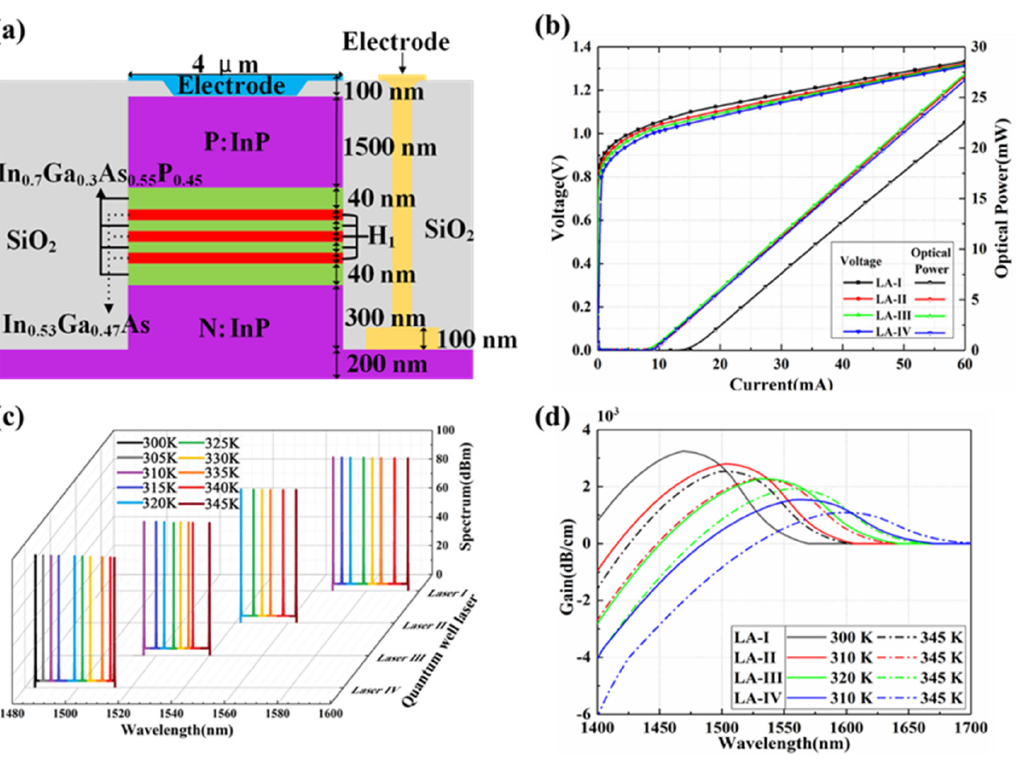
Figure 3. ( a ) The cross-section of the FP quantum well laser. ( b ) I–V curves of the four types of quantum well lasers. ( c ) Effects of temperature on the emission spectra. ( d ) Gain spectra of the four types of quantum well